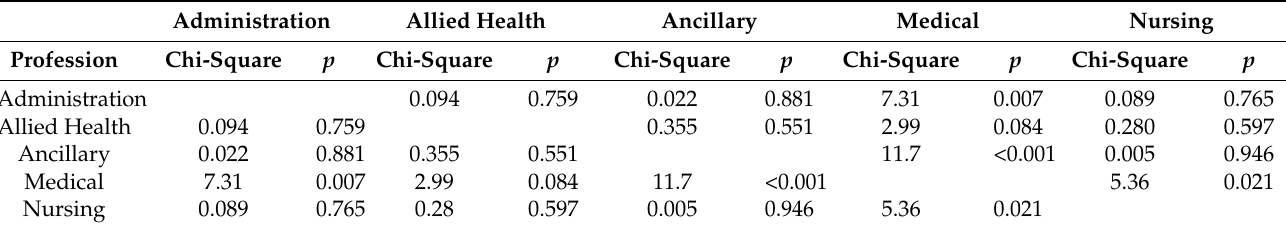
Table 2. Log rank test for Time to 1st dose among professions.